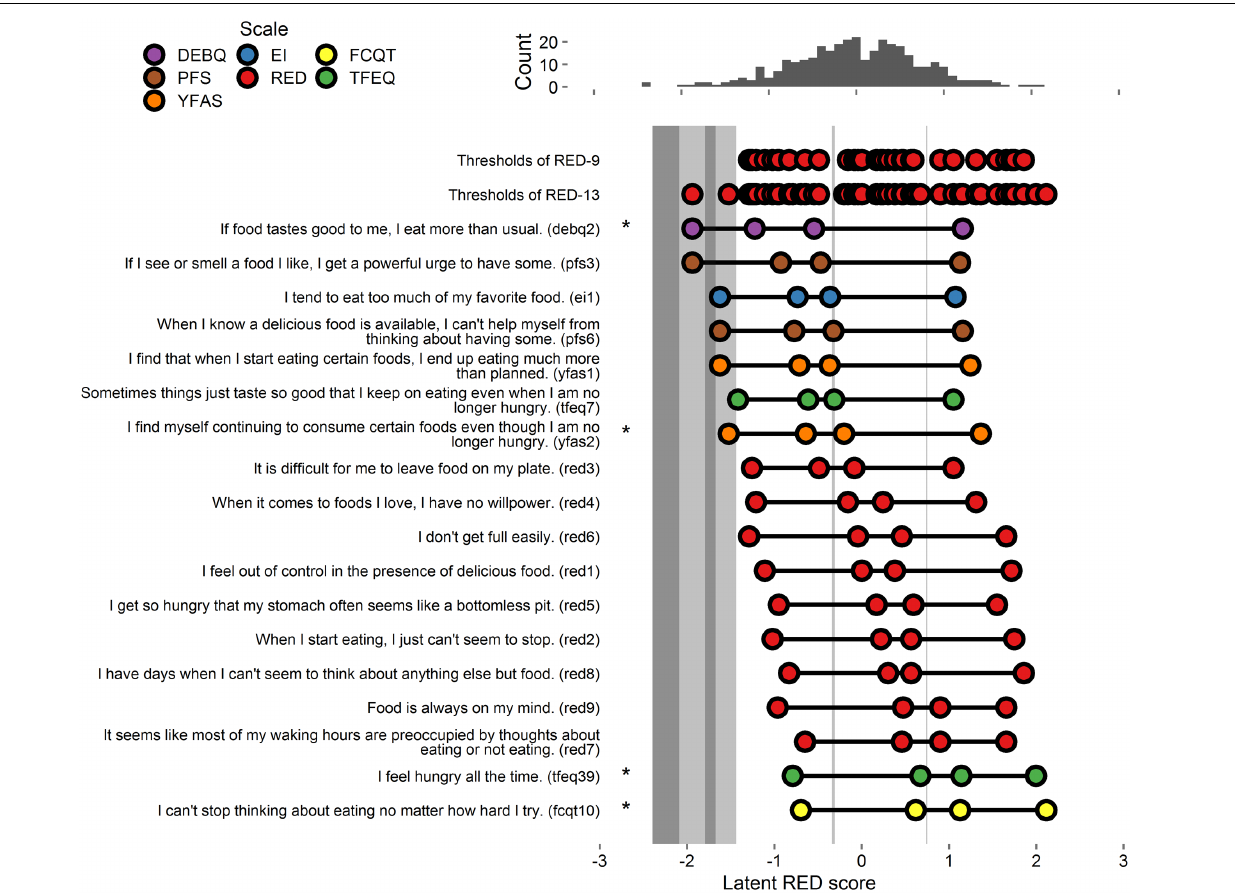
FIGURE 4 | Person-item map and histogram depicting thresholds on the spectrum of RRE for Study 4. See Figure 1 note. Bars in darker gray indicate gaps in RRE coverage left by the RED-13. Bars in lighter gray indicate gaps in coverage left by RED-9. Stars indicate items added to the RED-9 to form the RED-13.